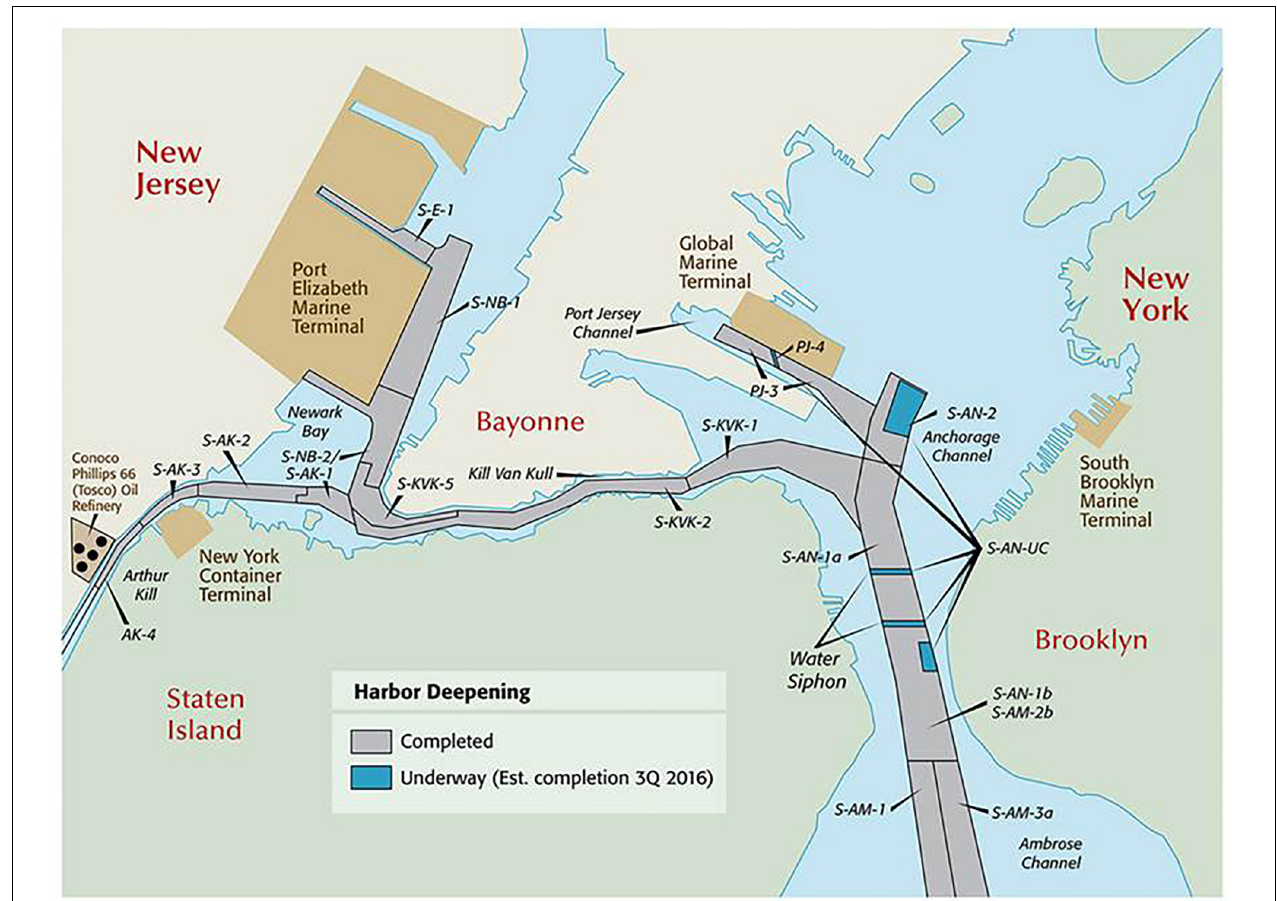
FIGURE 1 | Channel deepening projects in the NY-NJ Harbor, as of September 2016. Source: Port of New York and New Jersey (PNYNJ) (2016). Permission has been received for all previously published copyrighted